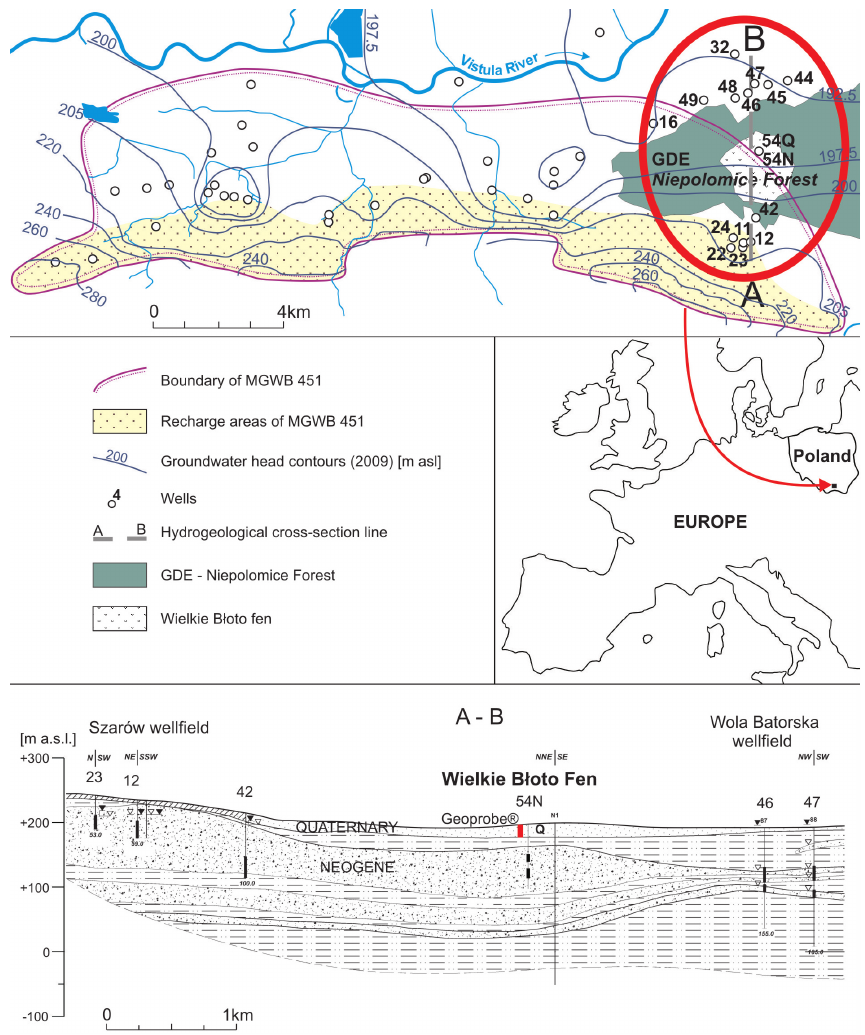
Figure 1. Hydrogeological map and cross-section of the Bogucice Sands (Neogene) aquifer (major groundwater basin – MGWB 451). The study area is marked by a red oval. Open circles mark the position of pumping wells. Cross-section according to Górka et al.